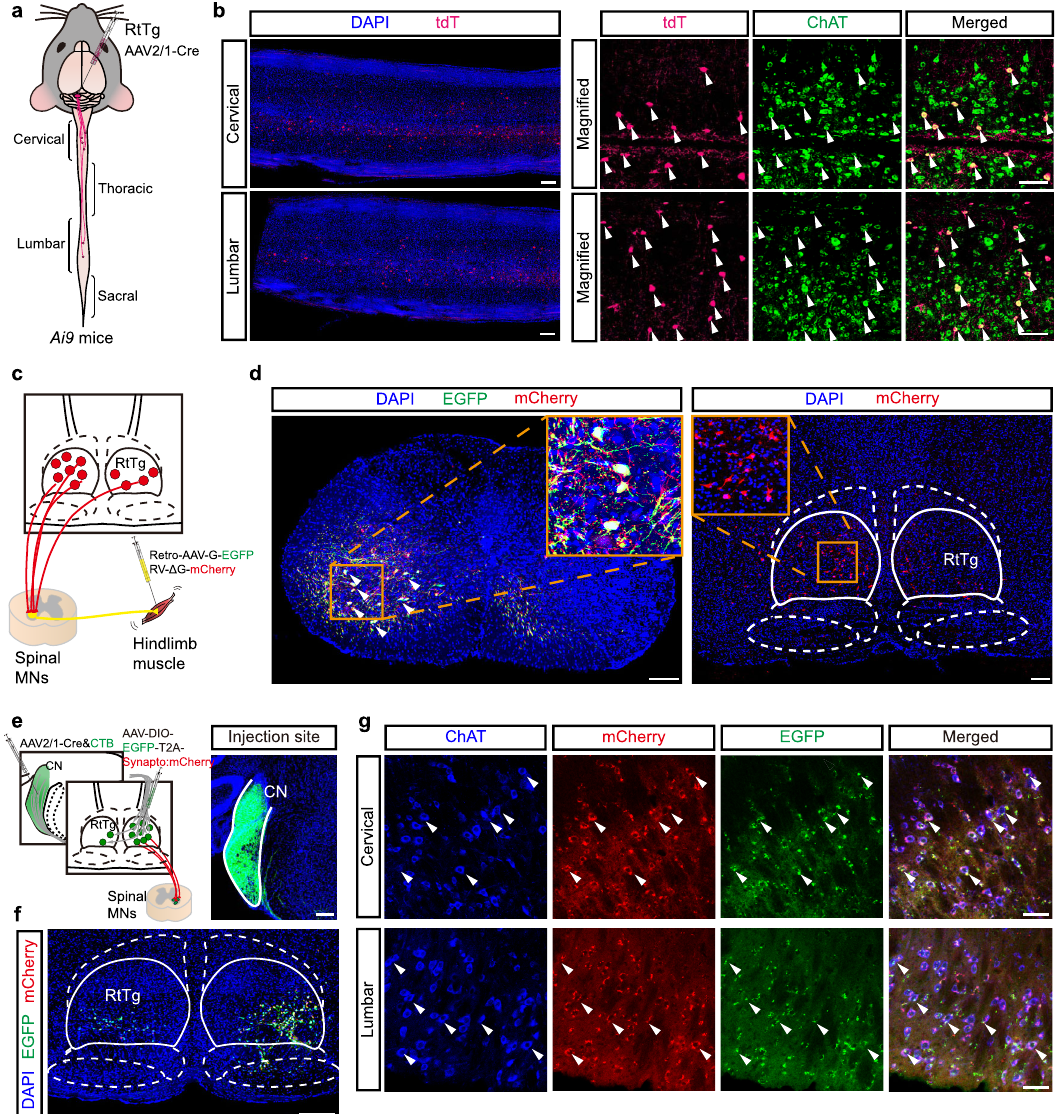
Fig. 6 Viral tracing of the CN-RtTg-MNs circuit. a Schematic for the AAV2/1-Cre-based anterograde transsynaptic tracing from the RtTg to multiple spinal cord segments. b Representative images showing the tdT + neuron labelling in transverse sections of spinal cervical and lumbar segments, and the co-labelling of tdT with ChAT (white arrowheads). Scale bar, 100 μ m. c Schematic for rabies virus-based retrograde monosynaptic tracing from hindlimb muscles to the RtTg. d Representative images showing EGFP + mCherry + spinal starter MNs (left) and mCherry + neurons in the RtTg (right). Scale bar, 200 μ m. e Left: schematic for the multilevel anterograde tracing from the CN to the spinal cord by injecting AAV2/1-Cre (mixed with CTB to visualize injection site) into the CN, followed by the injection of AAV-DIO-EGFP-T2A-Synaptophysin:mCherry into the contralateral RtTg. Right: a